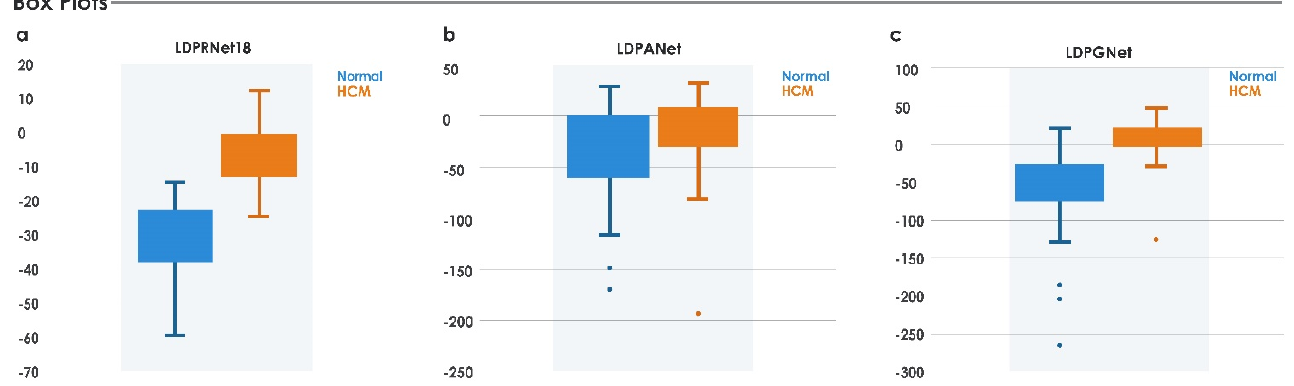
Figure 11. Classification using proposed IIHCM methodology with the LDPRes870 feature on di- vided training (70%) and testing data (30%). We synthetically generated minority class samples using an adaptive synthetic (ADASYN) sampling approach [65]. ADASYN uses the weighted distribution of minority data and reduces the bias that is introduced due to an imbalanced dataset. As a result, we obtained 198 samples (i.e., normal = 101 samples and HCM = 97 samples) after ADASYN. Further, the obtained LDP- RNet50 features of all the samples were analyzed using the t- distributed stochastic neighbor embedding (t-SNE) technique, which helped to visualize data by reducing its dimensions [66]. Figure 12 shows the data visualization of ranked LDP- RNet50 features using t-SNE.